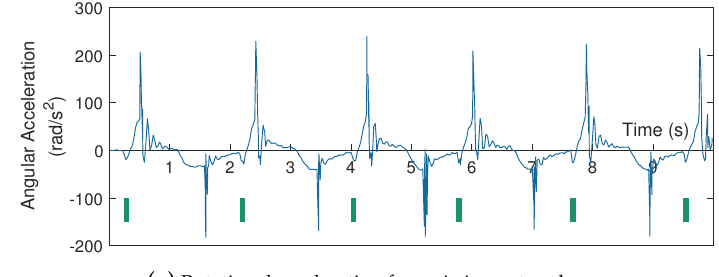
( a ) Rotational acceleration from six impact cycles.